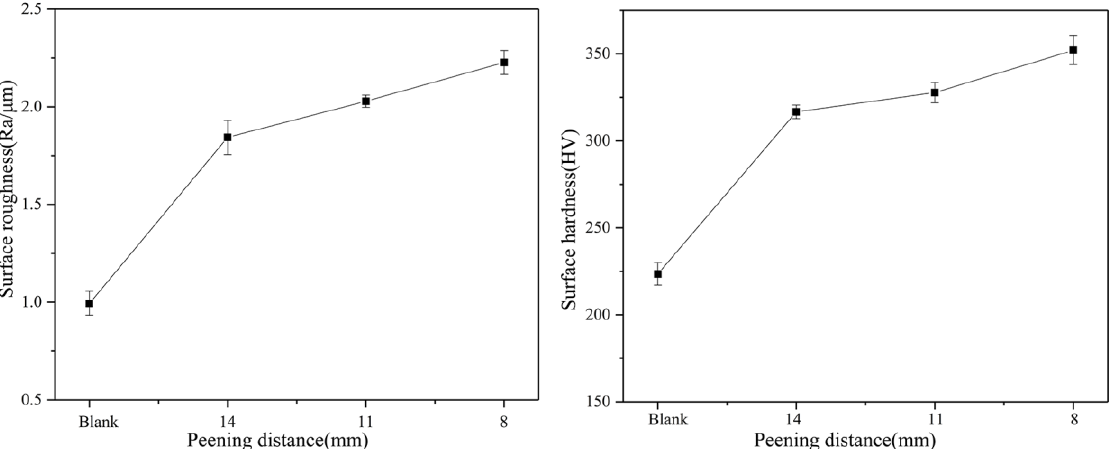
Figure 9. Surface roughness and microhardness evolutions of USPed samples with different dis- tances.